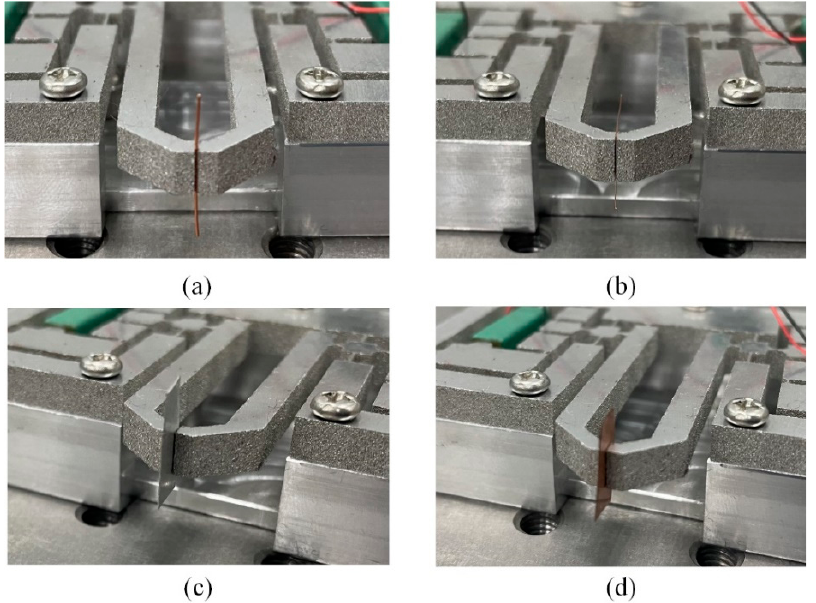
Figure 11. The manipulation of the: ( a ) wire with diameter of 200 µm, ( b ) wire with diameter of 100 µm, ( c ) slice with the thickness of 200 µm, ( d ) slice with the thickness of 150 µm. 100 µ m, ( c ) slice with the thickness of 200 µ m, ( d ) slice with the thickness of 150 µ